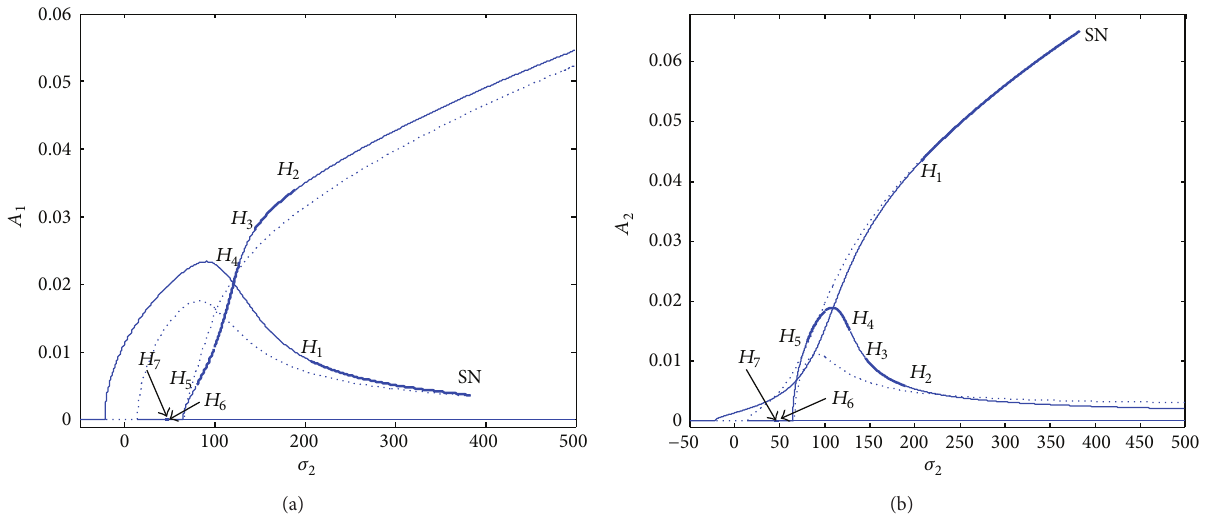
Figure 8: Effect of external damping parameter on the frequency response of first mode (a) and second mode (b) for 𝜇 = 0.05 , 𝛼 = 0 , V 1 = 10 , = 40 , and 𝜎 = 92.39 . V 𝑙 1